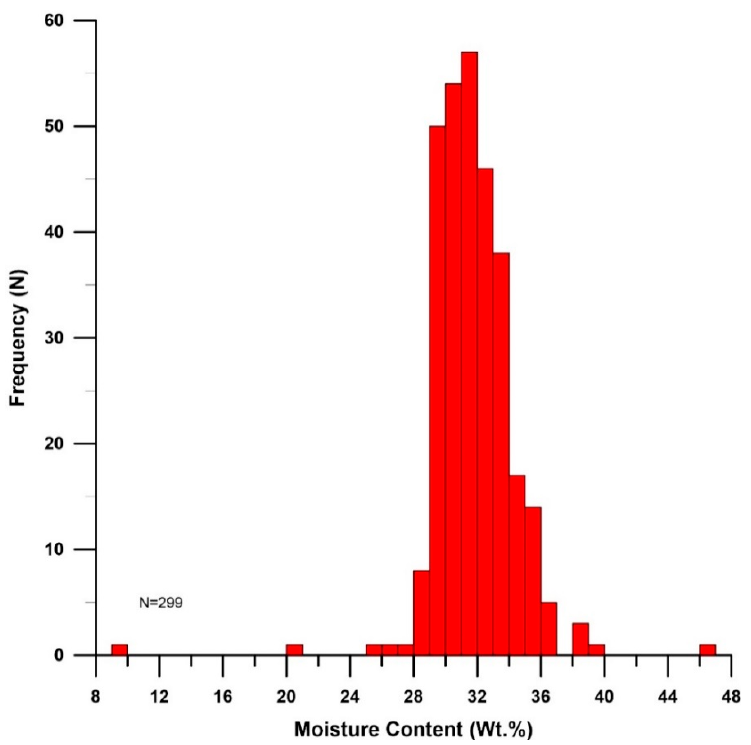
Figure 10. Water content (i.e., moisture contained in the pore space, in wt.%) of Mn nodules from Area E1.